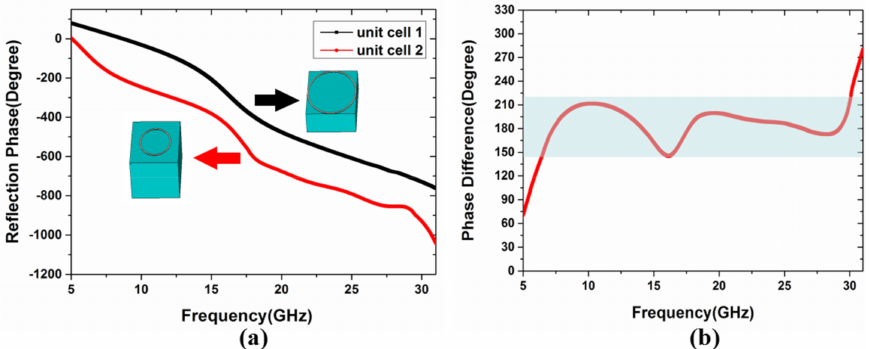
Figure 3. ( a ) The reflection phase and ( b ) the phase di ff erence of the unit